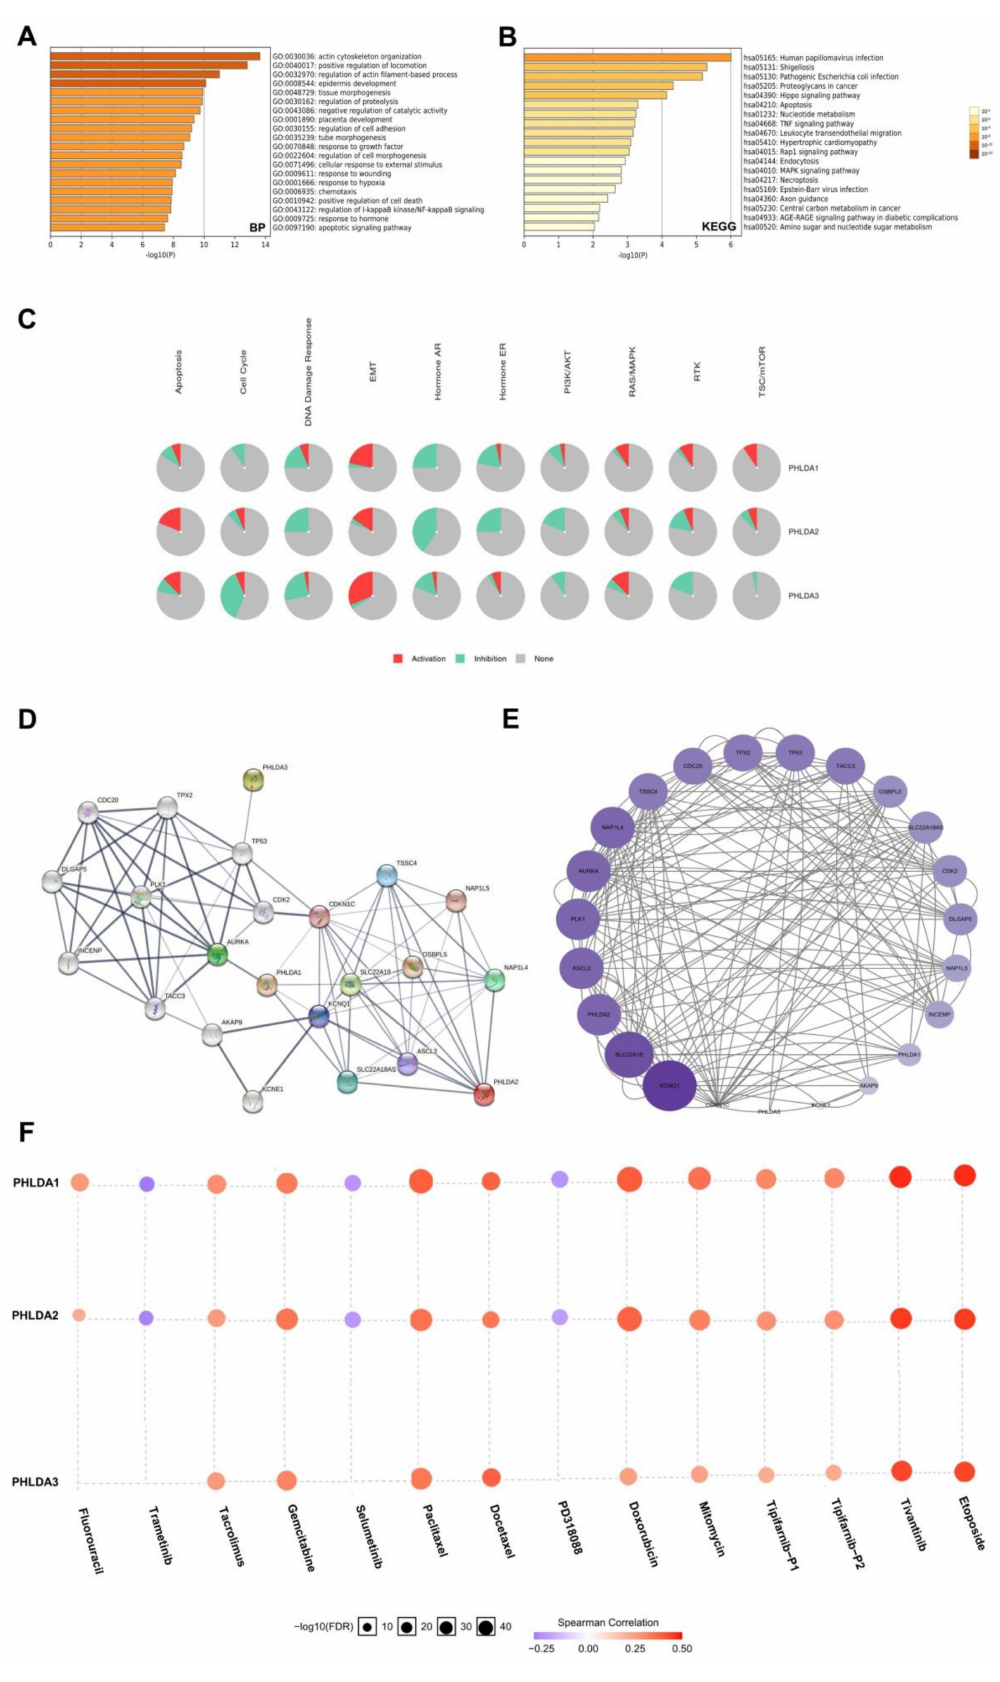
Figure 5. Gene enrichment analysis, PPI network construction, and drug sensitivity analysis of PHLDA Family in PAAD. ( A ) The GO enrichment of the BP terms of the PHLDA family and its